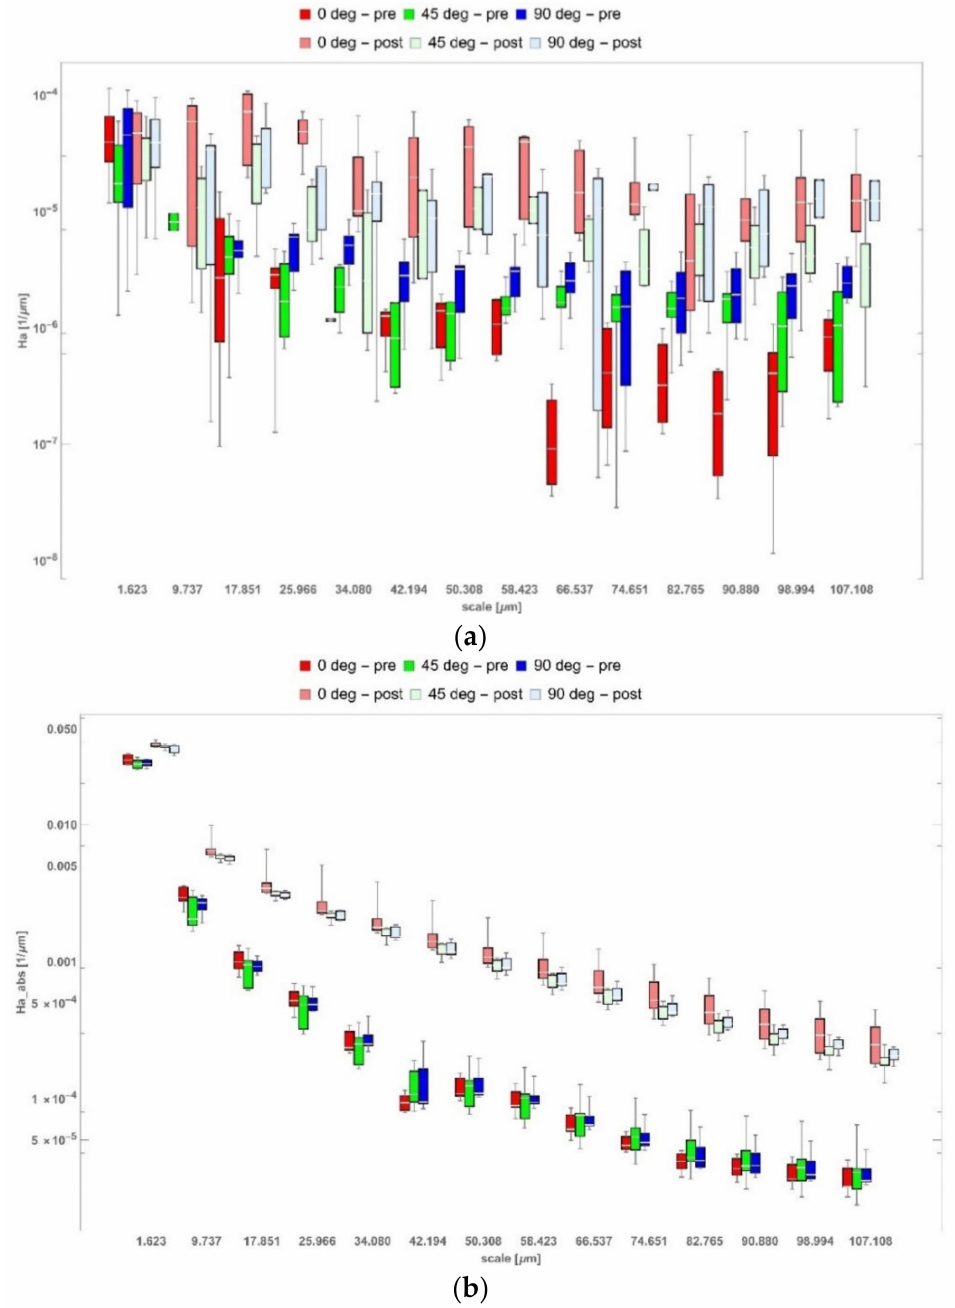
Figure 6. Evolution of selected curvature parameters with scale: ( a ) average mean curvature—Ha; ( b ) average absolute mean curvature—Ha abs . Please note that “pre” and “post” terms refer to postprocessing via